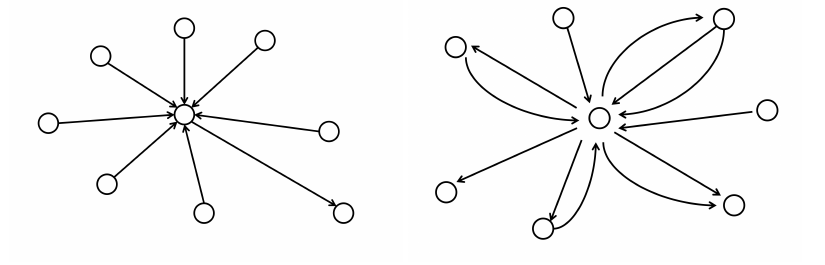
Figure 1. Direction of phishing and normal network